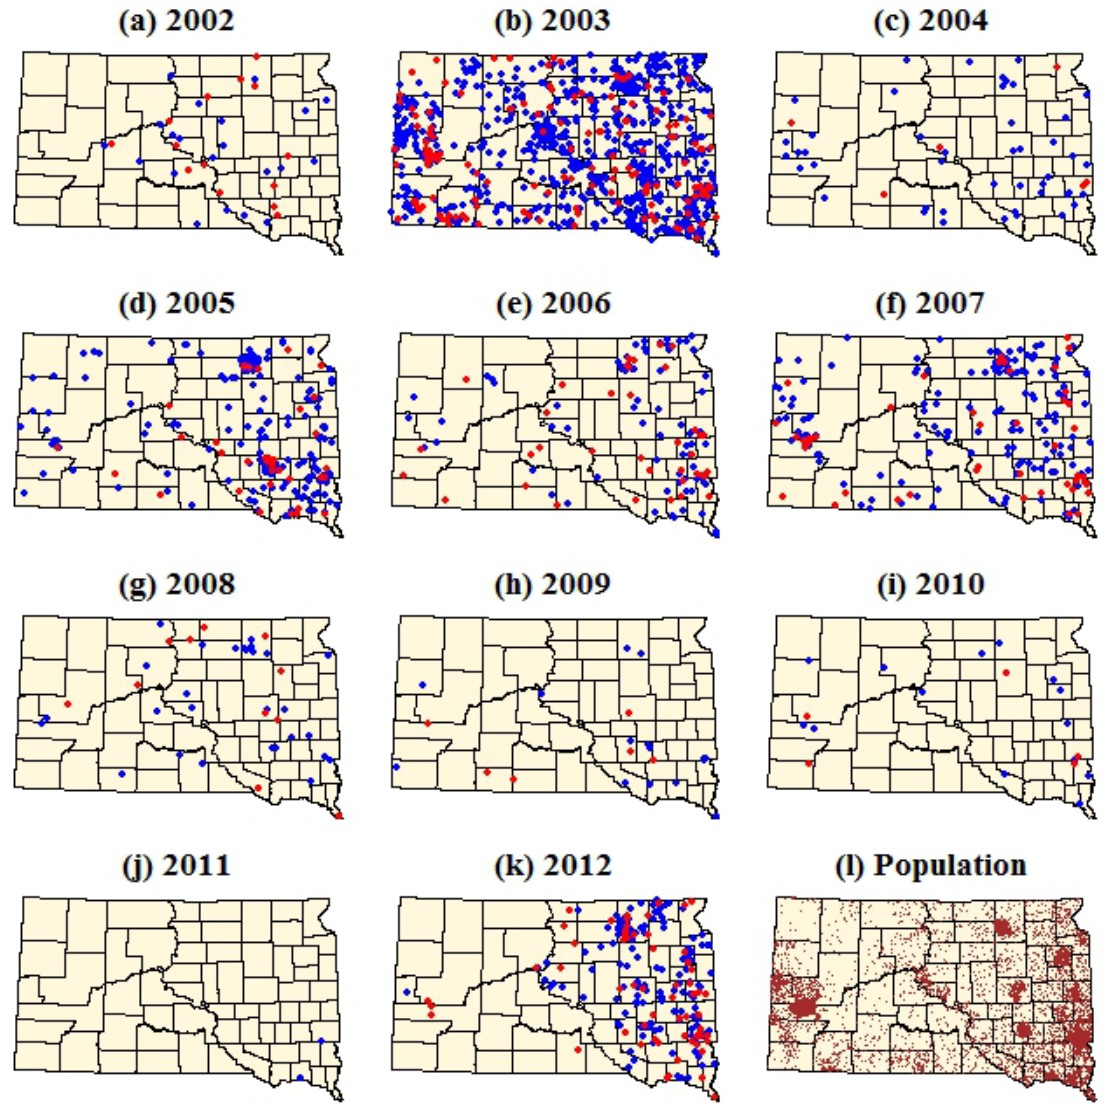
Figure 2. Dot density maps of WNV cases in South Dakota from 2002–2012. ( a – k ) Each dot represents a single case within the ZIP code tabulation area (ZCTA) of the patient’s residence. Red dots represent WNV neuroinvasive disease and blue dots represent WNV fever. ( l ) Brown dots represent total population with one dot per 100 people. Dots were assigned random locations within the ZCTAs for the purpose of